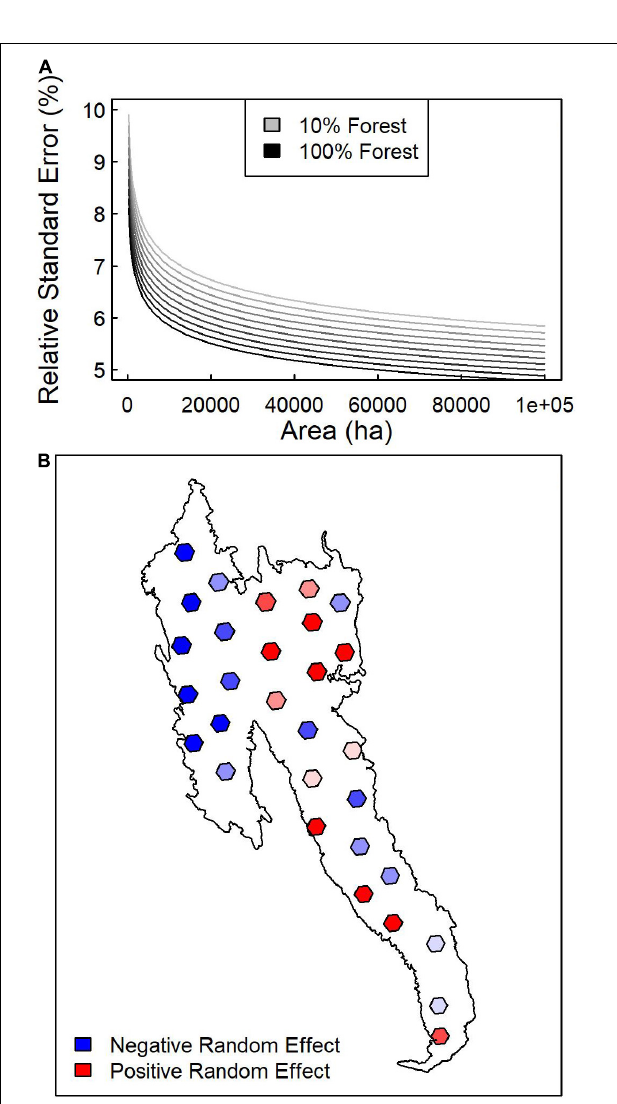
FIGURE 6 | Mixed effects regression results of relative standard error as a function of scale and landscape. (A) Mean predictions of coefficient of variation based on forested area and forest dominance (percent of AOI that is forested). (B) Spatial distribution of random effects across study area.